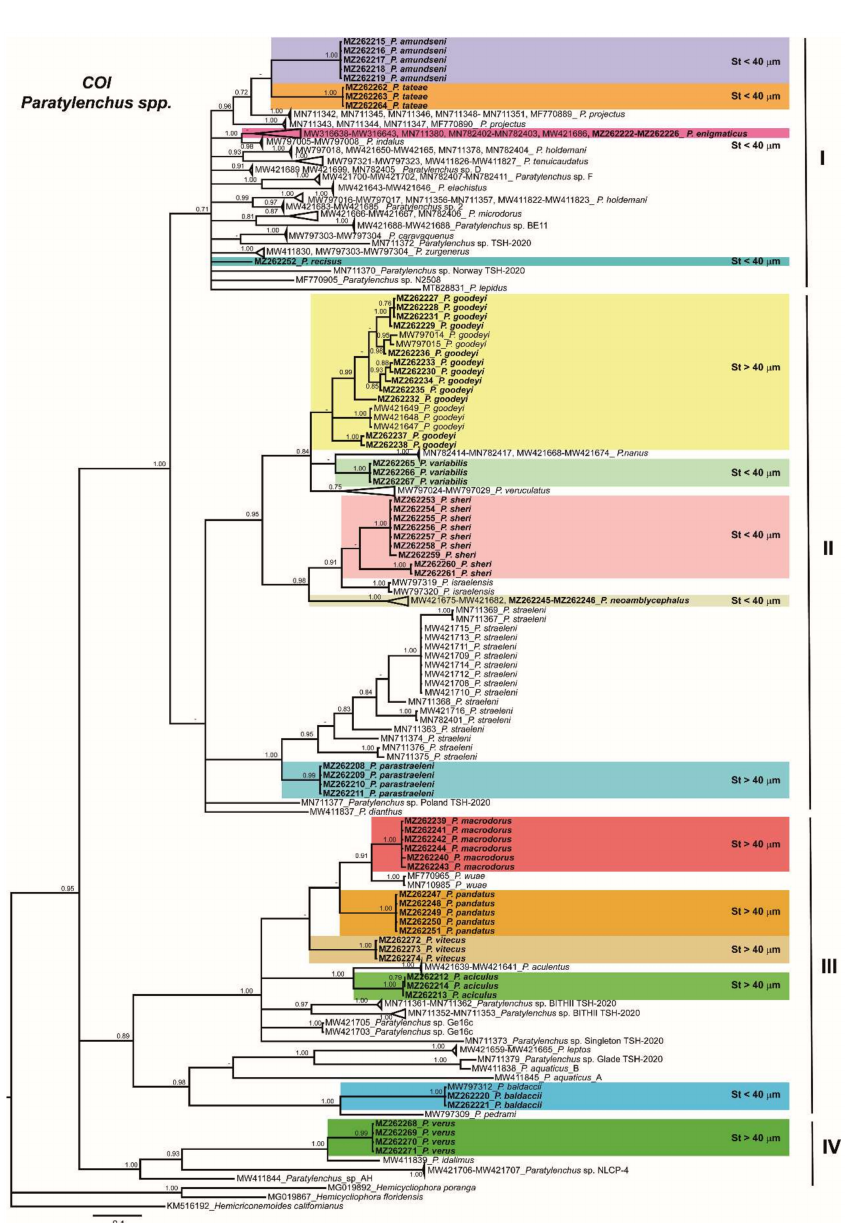
Figure 18. Phylogenetic relationships within the genus Paratylenchus . Bayesian 50% majority rule consensus tree as inferred from cytochrome c oxidase subunit 1 (COI) sequence alignment under the general time-reversible model of sequence evolution with a gamma-shaped distribution (GTR + G). Posterior probabilities of more than 0.70 are given for appropriate clades. Newly obtained sequences in this study are shown in bold. The scale bar indicates expected changes per